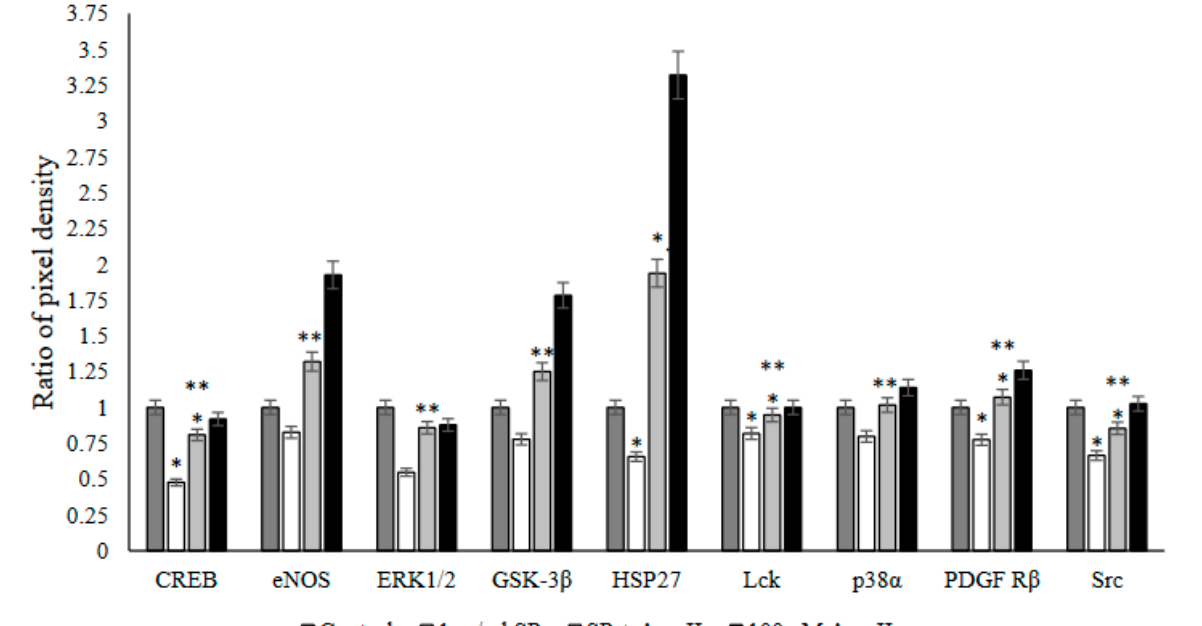
Figure 7. Phospho-kinase array analysis of PBMCs from recovered COVID-19 patients (n = 13) after stimulation of PBMCs with a SARS-CoV-2 peptide pool (SP), angiotensin II (Ang II), or both of a SP and Ang II. The ratio of pixel density was measured as the mean of the pixel density of each group to the mean of the pixel density of the control group. Out of the 21 tested proteins, only the proteins which showed significant changes in phosphorylation by both of the SARS-CoV-2 peptide pool (SP) and angiotensin II (Ang II) stimulation are shown. *, p < 0.05 vs. control group; **, p < 0.05 vs. 1 µg/mL SARS-CoV-2 peptide pool group.